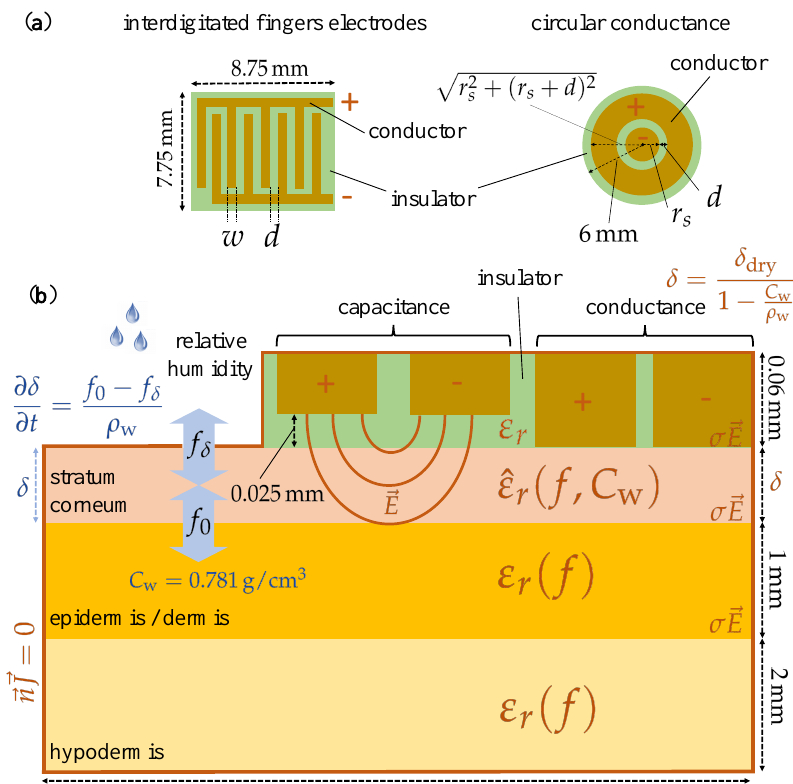
Figure 1. Pictorial description of the numerical model, with dimensions and boundary conditions, developed in this work to investigate the electrode-based stratum corneum hydration measurement. ( a ) Interdigitated fingers electrode ( left ) and circular conductance electrode ( right ) with the outer driving and inner sensing electrodes and their respective dimensions. In this study, w , d and r s were varied to investigate the effect of the electrode dimensions on the electrode sensitivity. ( b ) Skin model. The skin is modelled as a multilayer material (stratum corneum, epidermis/dermis and hypodermis). The thickness, as well as the dielectric properties of the stratum corneum varies with hydration, whereas properties of other layers are taken constant. We assume discontinuity of the electric field between the different layers due to different dielectric properties. The skin is insulated at its outer borders ( (cid:126) n (cid:126) J = 0). The conductance electrode (in electrical contact with the skin) and capacitance electrode (insulation layer between the electrode and the skin) are both investigated in this work. The electric field results from a potential difference between the two